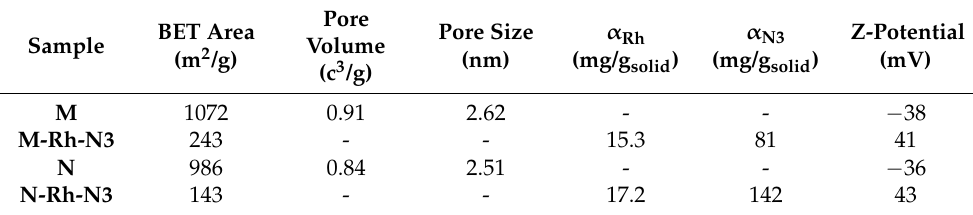
Table 1. Characterization of the mesoporous silica particles (MSPs) before and after functionalization: Brunauer–Emmett–Teller (BET) specific surface area, pore volume, and pore size calculated from the N 2 adsorption–desorption isotherms, content of rhodamine B and amines ( α Rh and α N3 , mg/g solid ), and zeta potential (Z-potential, mV). M—microparticles; N—nanoparticles; Rh—loaded with rhodamine